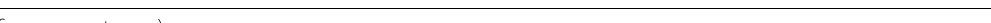
OLC group, n 8/group. + =